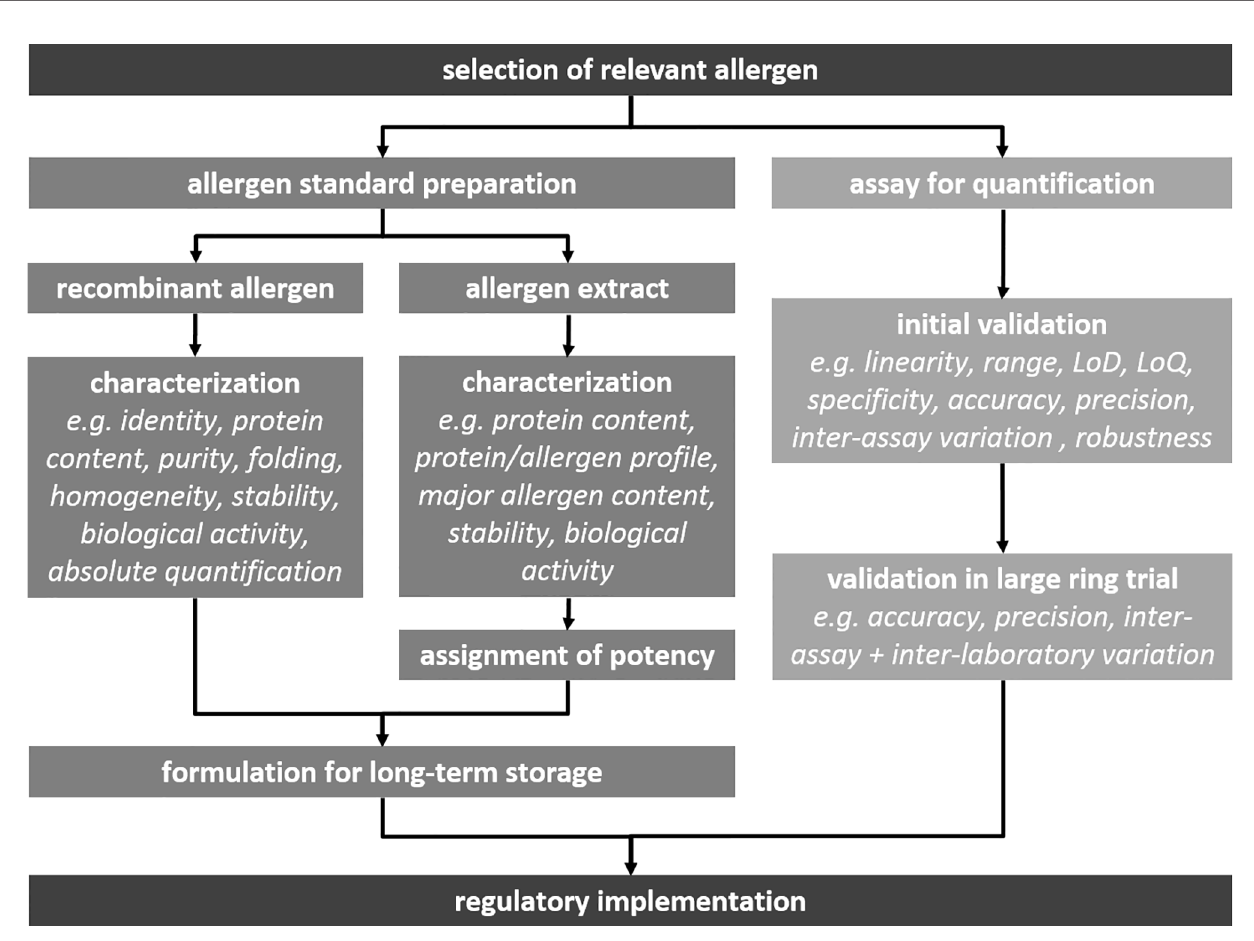
FIGURE 1 | Steps in the development of allergen standard preparations and methods in the